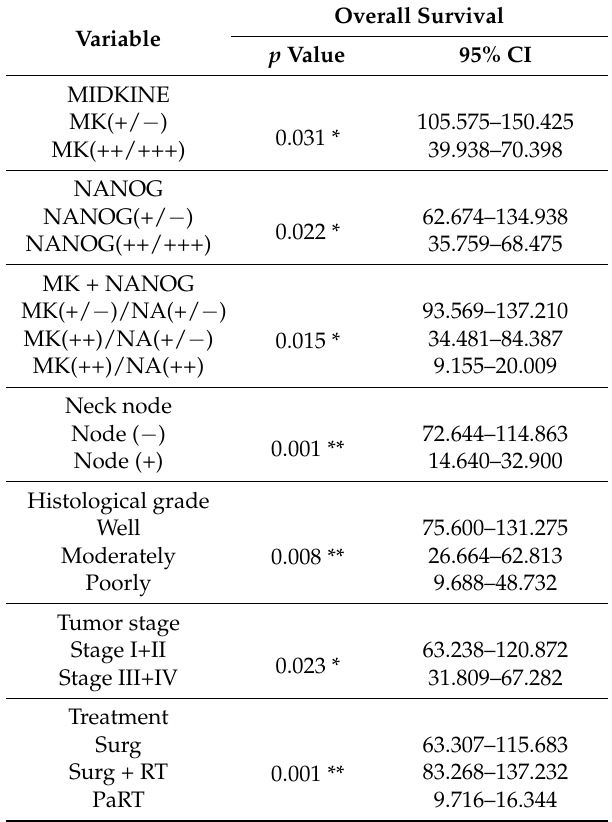
Table 2. Univariate (Kaplan–Meier survival analysis) analysis for variable in relation to overall survival of the 62 OSCC